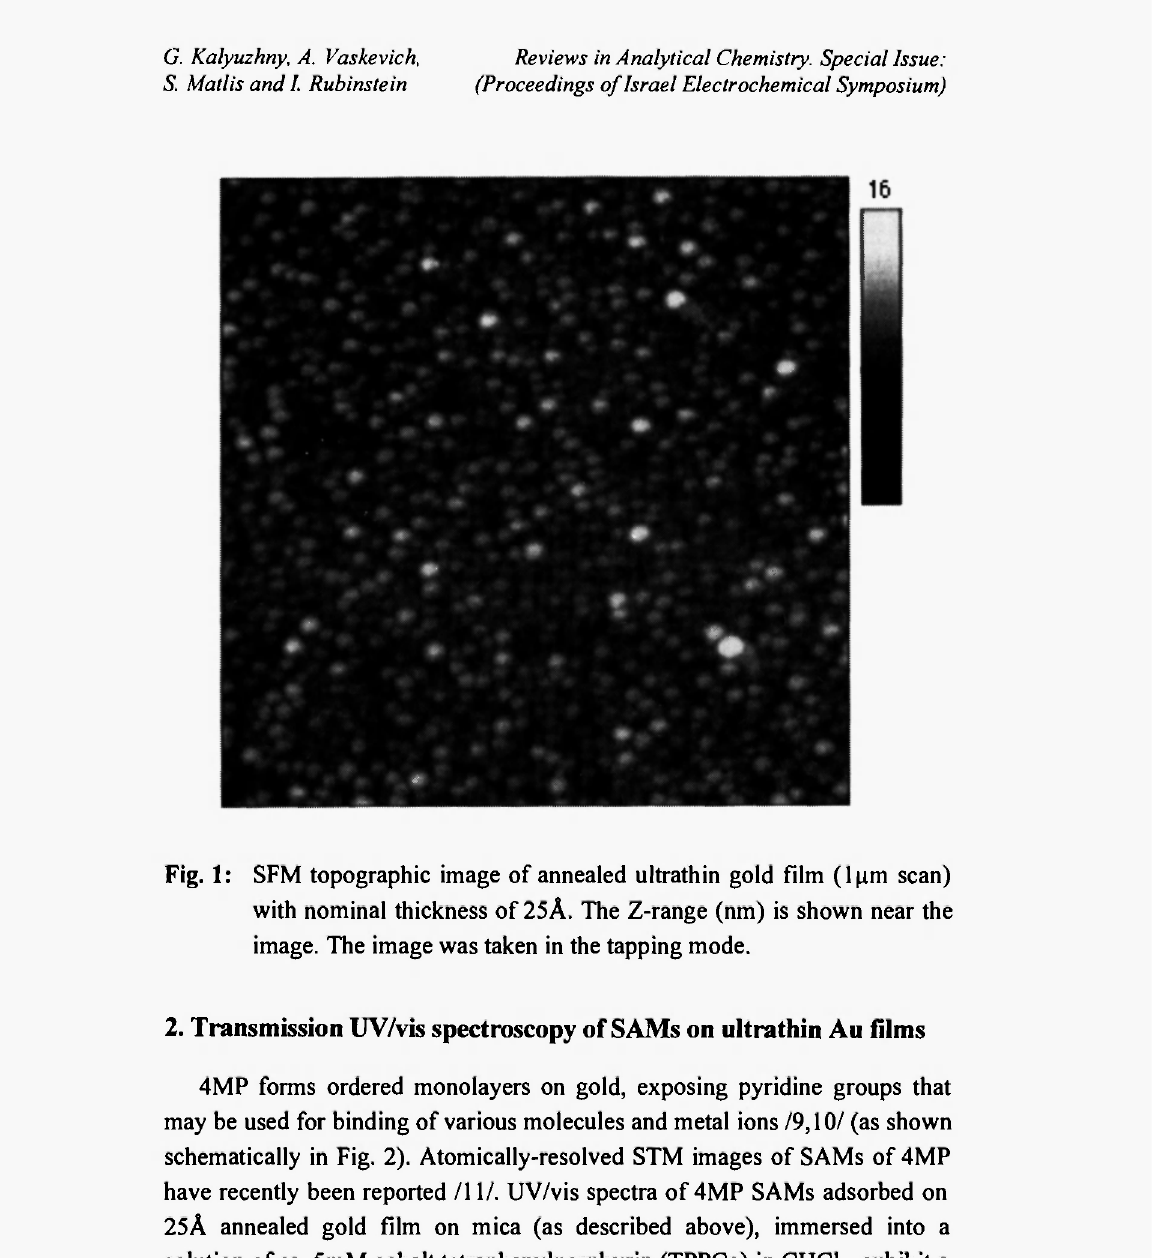
Fig. 1: SFM topographic image of annealed ultrathin gold film (1 μπι scan) with nominal thickness of 25Ä. The Z-range (nm) is shown near the image. The image was taken in the tapping